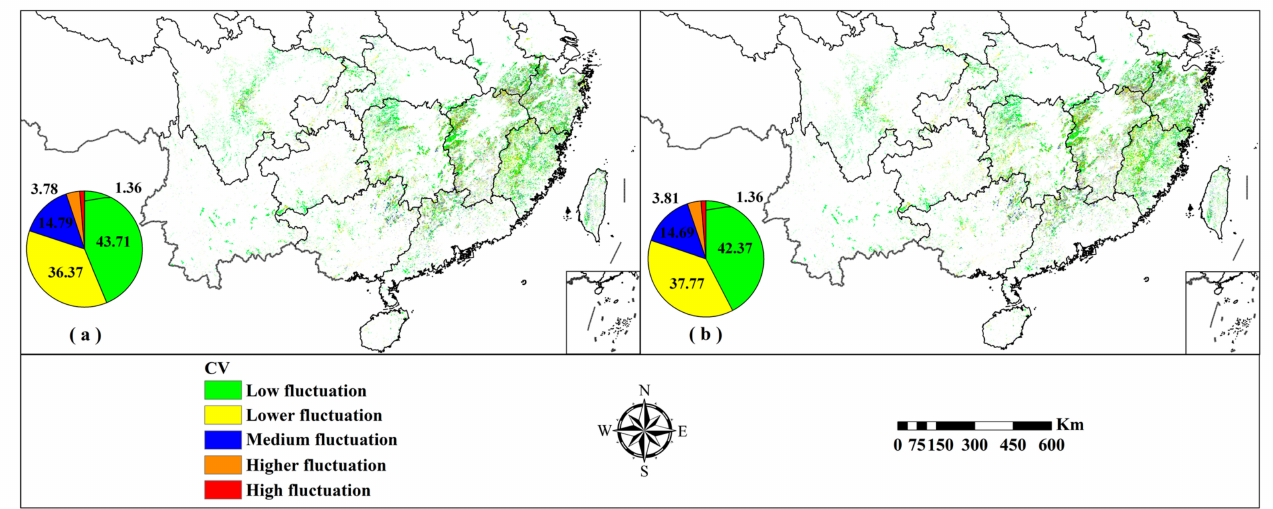
Figure 7. Spatial distribution of the variation coefficients (CVs) of the ( a ) GPP and ( b ) NPP of bamboo forests in China from 2001 to